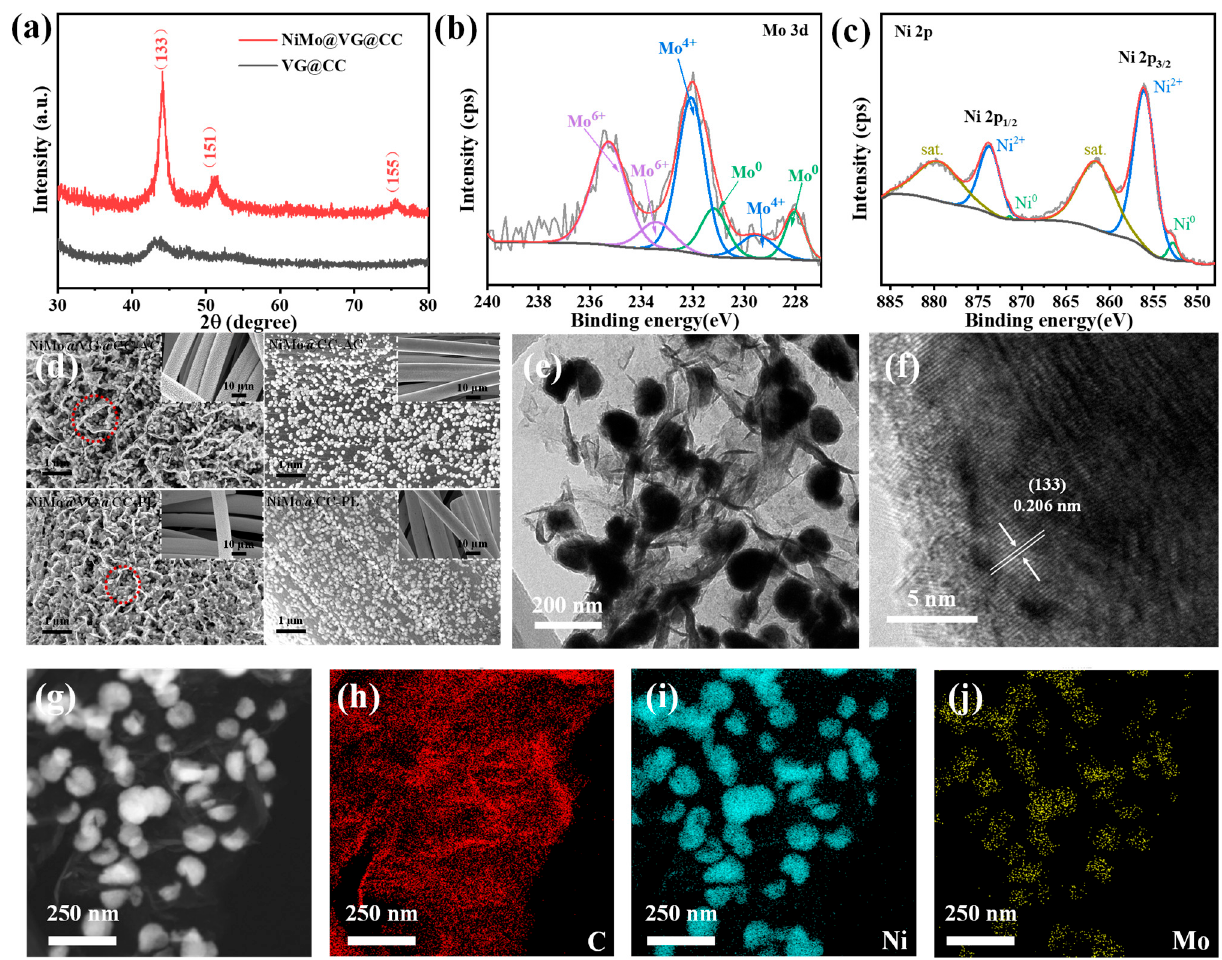
Figure 2. Structure and morphology characterizations of NiMo@VG@CC-AC. ( a ) XRD patterns; ( b , c ) High-resolution XPS spectra of Mo 3d and Ni 2p; ( d ) SEM; ( e , f ) TEM; ( g – j ) EDS mapping of C, Ni, and Mo.